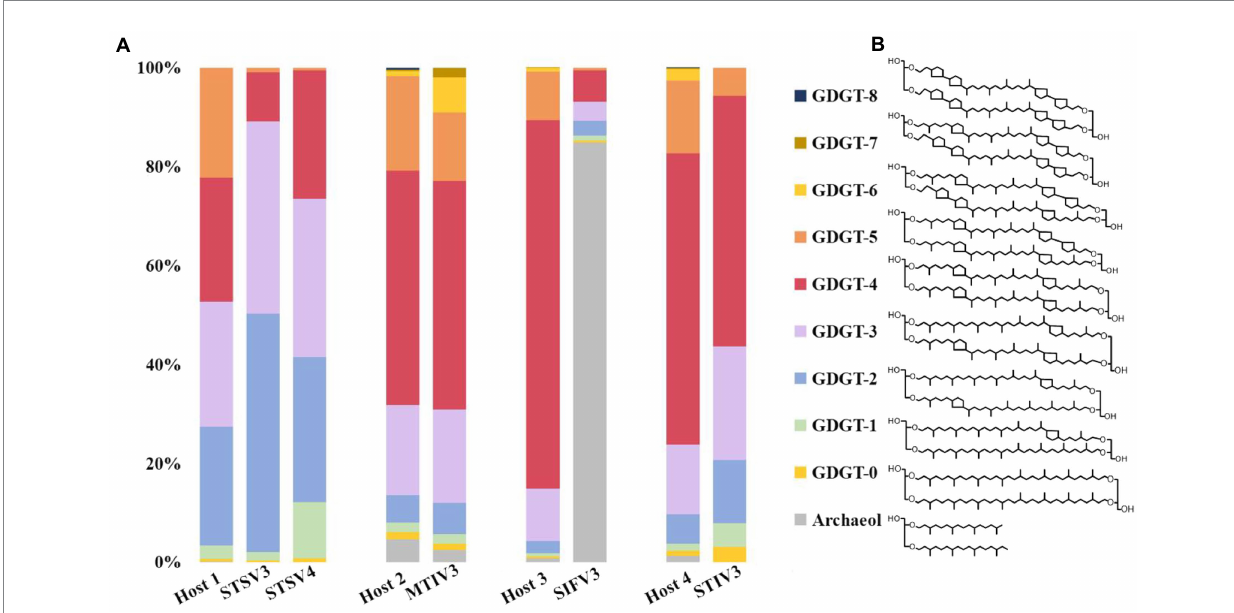
FIGURE 5 Distribution of lipid species identified in host cells and the highly purified virions. (A) The lipid compositions and the proportion of the virus envelope and host cellular membranes; (B) Chemical diagrams for the GDGT 0–8 (GDGT, glycerol dibiphytanyl glycerol tetraether) and archaeol. Host 1: Sulfolobus sp. 1,201–2/1201–4; Host 2: Metallosphaera sp. D4-4; Host 3: Saccharolobus sp. 1,201–1; Host 4: Sulfolobus sp.